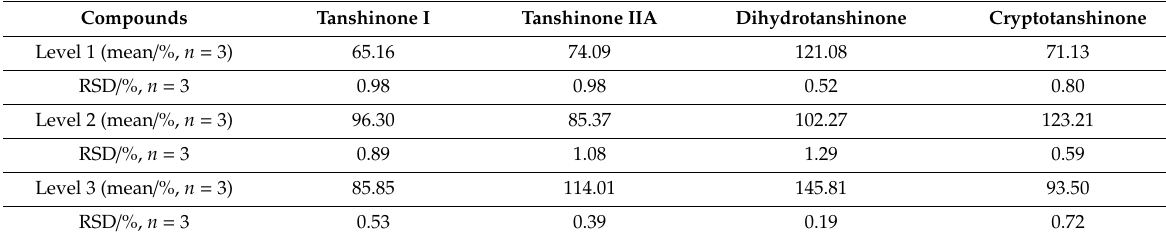
Table 3. Accuracy test results.